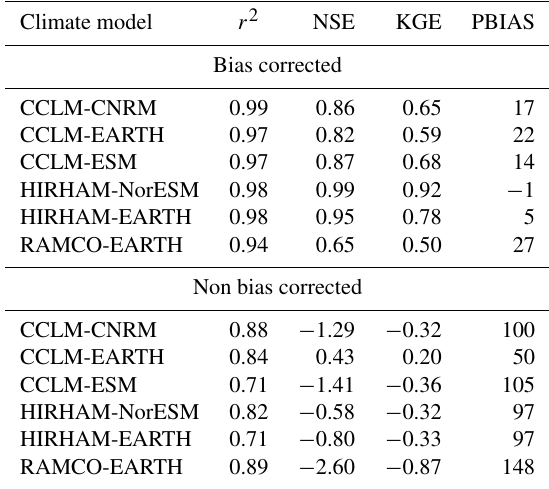
Table 4. Performance of RCM–GCM based discharge compared to observation based discharge. Performance is calculated using mean monthly discharges for the period 1971–2000.